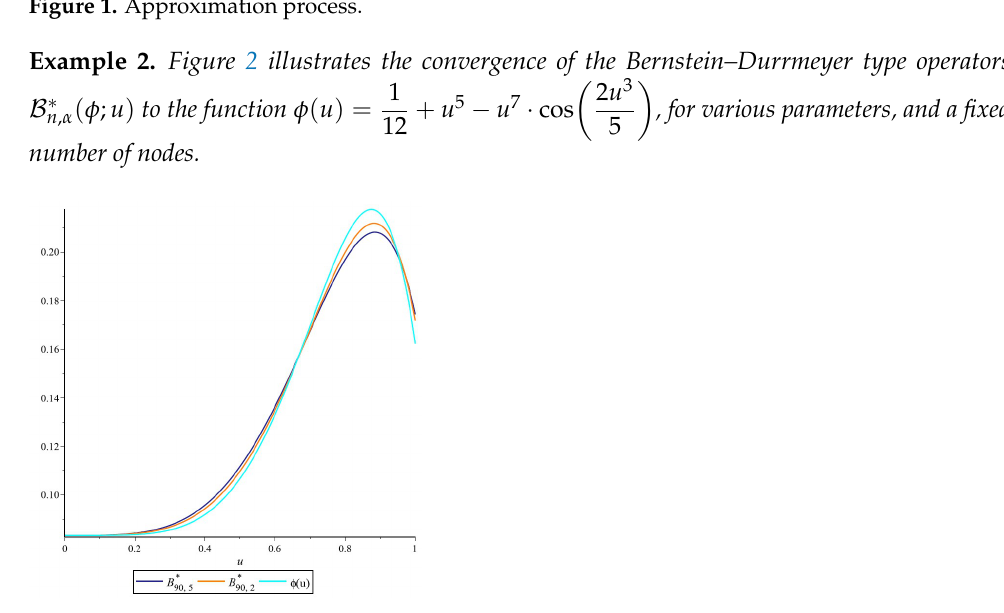
Figure 2. Approximation